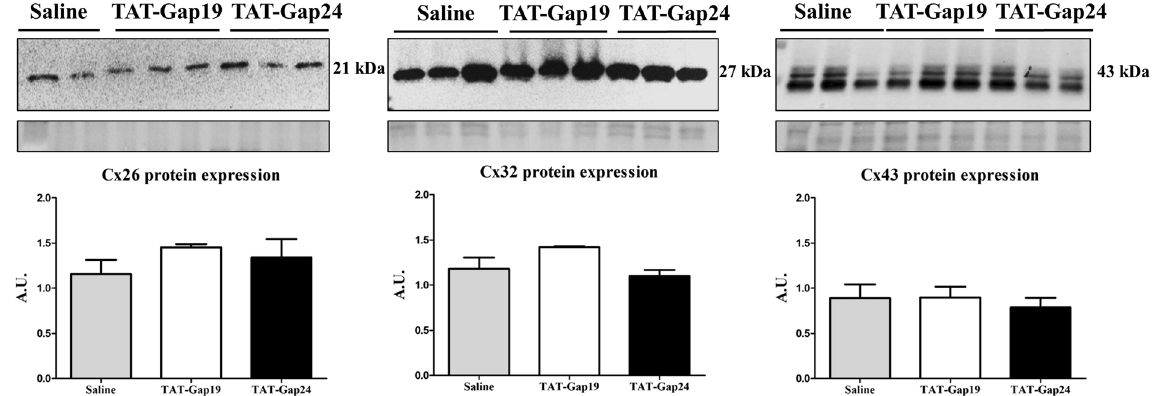
Figure 2. Effects of TAT-Gap24 and TAT-Gap19 on connexin protein expression in liver. After 8 weeks of CHFD, an osmotic pump was surgically implanted in the abdominal cavity, which ensured sustained release of 1 mg/kg/day TAT-Gap24 (n = 11) or TAT-Gap19 (n = 12) or saline (n = 14) for another 2 weeks, while continuing the diet. Immunoblot analysis of Cx26 (21 kDa), Cx32 (27 kDa) and Cx43 (43 kDa) after separation and blotting, after which results were normalized to total protein loading. Blot images are cropped. Full-length blots are presented in Supplementary Fig. 4. Data are expressed as means ± SEM.